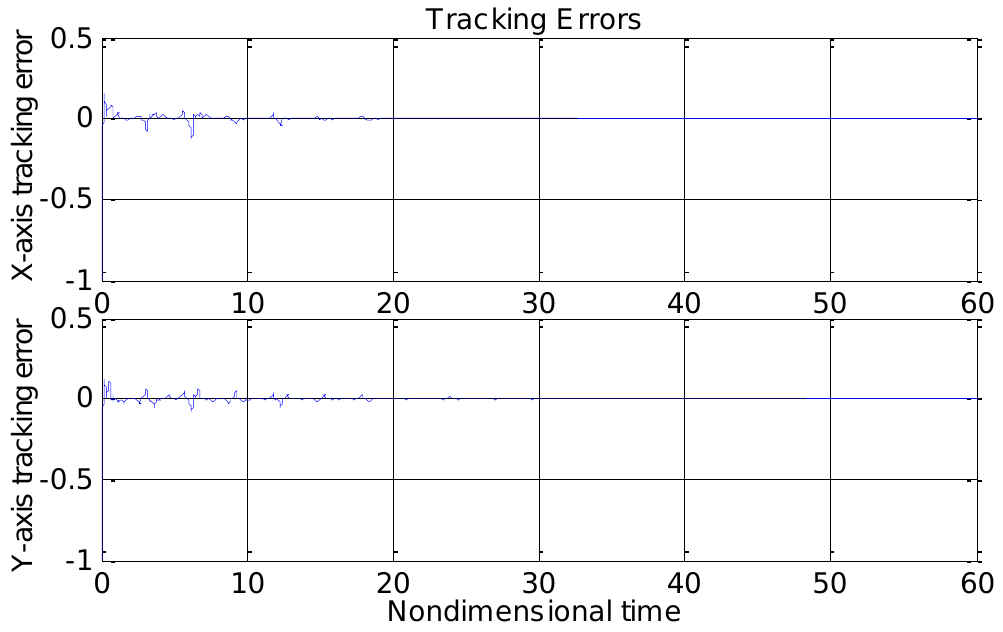
Figure 4. Tracking errors using the adaptive backstepping control (ABC) approach.